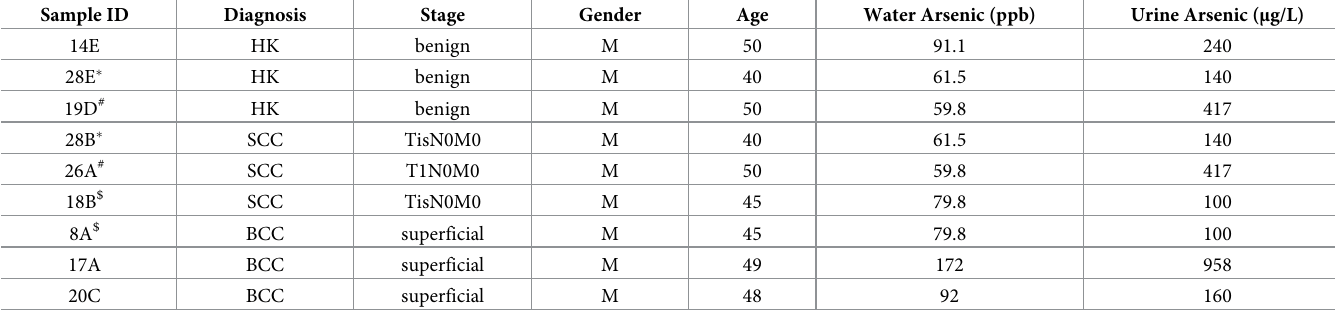
Table 1. Demographic and diagnostic data on arsenic-induced skin lesion samples used for miRNA analyses.